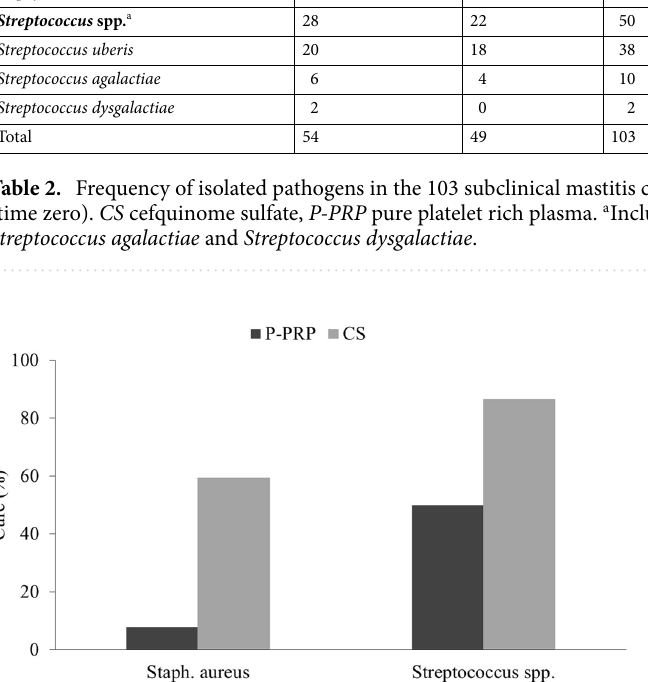
Figure 3. Overall bacteriological cure rate among cows with subclinical mastitis caused by Gram-positive pathogens, which were treated with either 10 mL of intramammary P-PRP (pure platelet rich plasma) or 75 mg of intramammary CS (cefquinome sulfate) over three consecutive milkings, Streptococcus spp. includes only Streptococcus uberis , Streptococcus agalactiae and Streptococcus dysgalactiae .